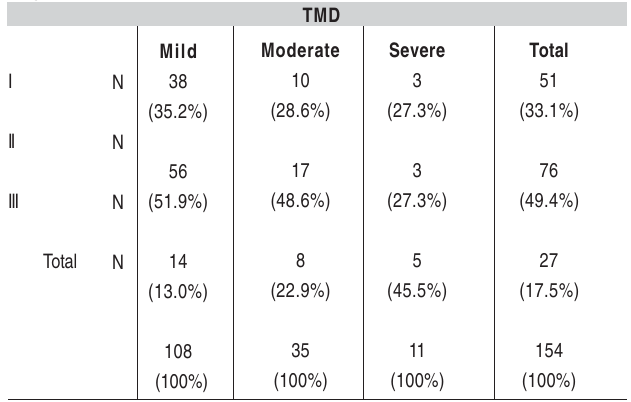
Table 4. Classification of occlusal angle for the different degrees of TMD.